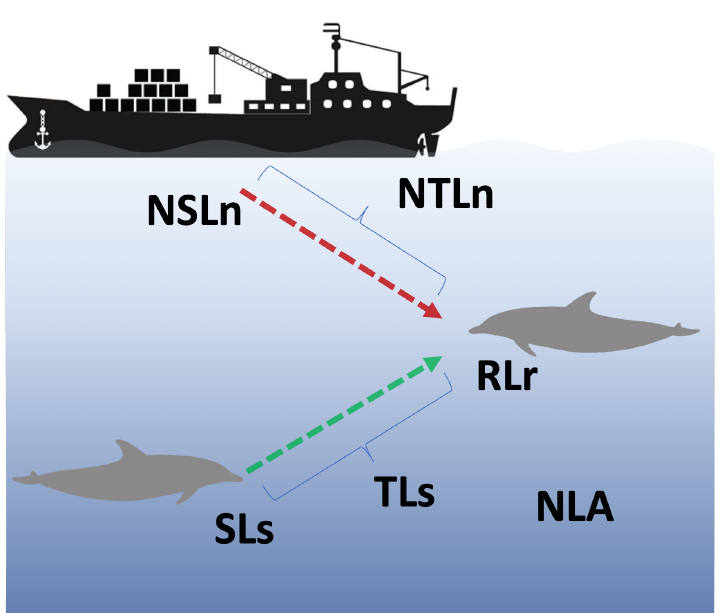
Figure 5. Conceptual scheme that represents the communication process between individuals, taking into account all the variables involved in the distance reduction calculation. The variables considered are noise level radiated by the n-th source NSL n , transmission loss calculated from the n-th source NTL n , ambient noise level NL A , source level emitted SL s , transmission loss from the emitter or source to the receiver TL s , and received signal level RL r